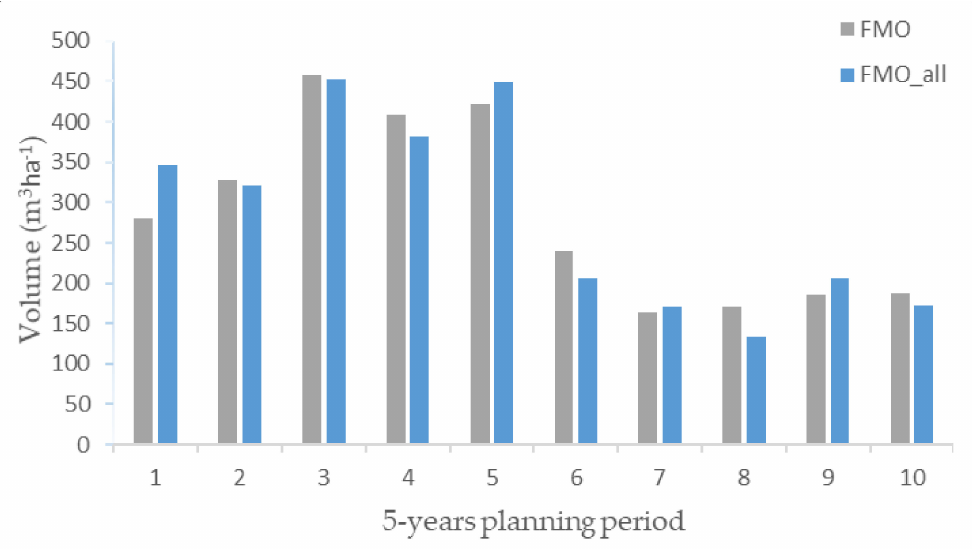
Figure 4. Removed timber volume (m 3 · ha − 1 ) by each five-years period during the planning horizon with models FMO (base model) and FMO_all (model with all constraints: bounding the final average age, area by classes of age regulation, balanced revenue of volume).